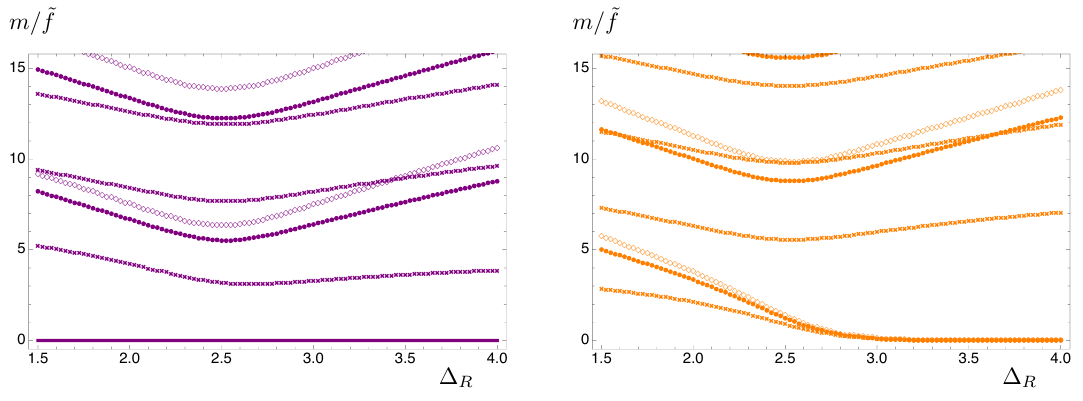
Figure 20 . Model I. Fermionic spectrum as a function of ∆ R for ∆ = 2 . 5 , g 5 = 8 , ˜ λ 0 , IR = ˜ λ (max) and x F = 0 . 5 , 2 , 4 (diamonds, dots, crosses). The left and right panels correspond to imposing (+) and ( − ) IR boundary conditions, respectively. The solid line in the left panel indicates the presence of a massless state. The ratio between the UV and IR energy scales is equal to Λ UV the IR regulator r 1 = 10 − 12 in the